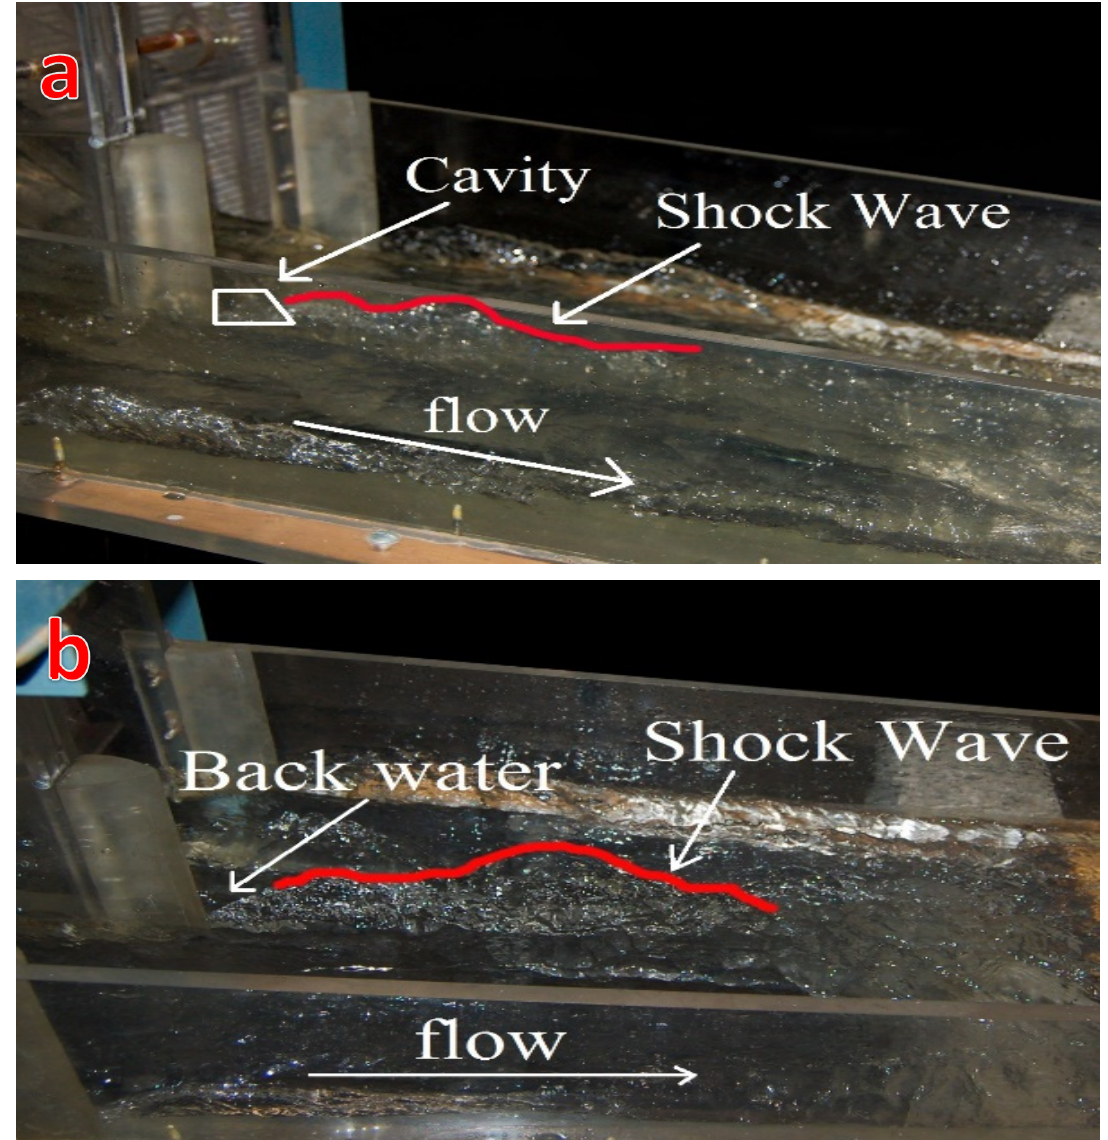
Figure 6. Cavity formation behind the pier. ( a ) Longitudinal view. ( b ) Plan view. Pressure